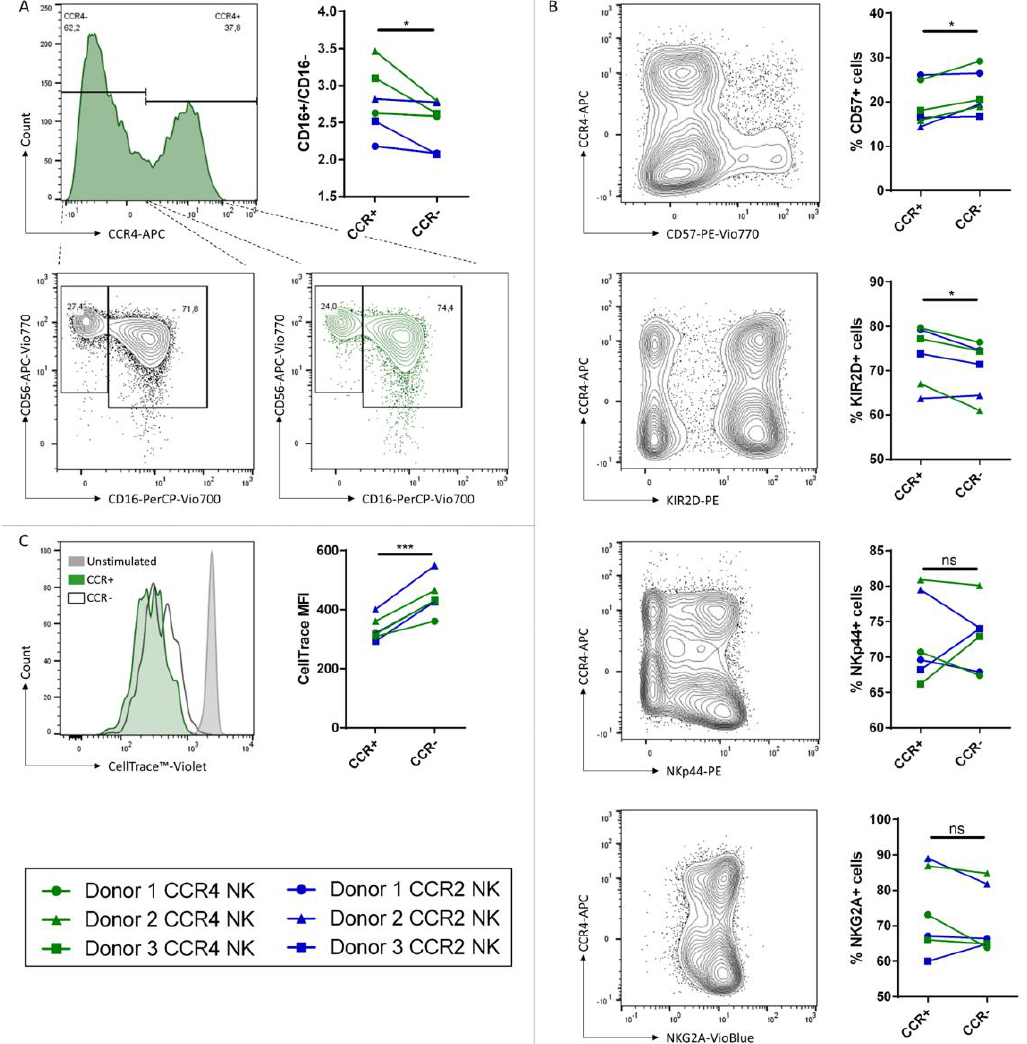
Figure 5. Characterization of different NK cell populations between transduced and untransduced NK cell fractions. Histogram plots show one representative out of n = 3 donors transduced with CCR4. Histograms from the CCR2B transductions were similar. Discrimination between transduced (CCR+) and untransduced (CCR-) fractions was performed by using the same gating strategy seen in histogram A. ( A ) CD56 and CD16 expression of transduced and untransduced fraction of a donor. Graph shows ratios of CD16-positive populations (CD16+) frequencies divided by CD16-negative populations (CD16 − ) frequencies. ( B ) Histograms show a representative distribution of cells by their expression of CCR4 and CD57, KIR2D, NKp44 or NKG2A. Graphs show frequencies of cells ex- pressing CD57, KIR2D, NKp44 or NKG2A. ( C ) Cells were analyzed for proliferative potential via CellTrace™ Violet staining. Histogram shows one representative that was transduced with CCR4. Graph shows the MFIs of each CellTrace signal of n = 3 independent experiments on 3 donors. *: p ≤ 0.05. ***: p ≤ 0.001. ns = not significant.